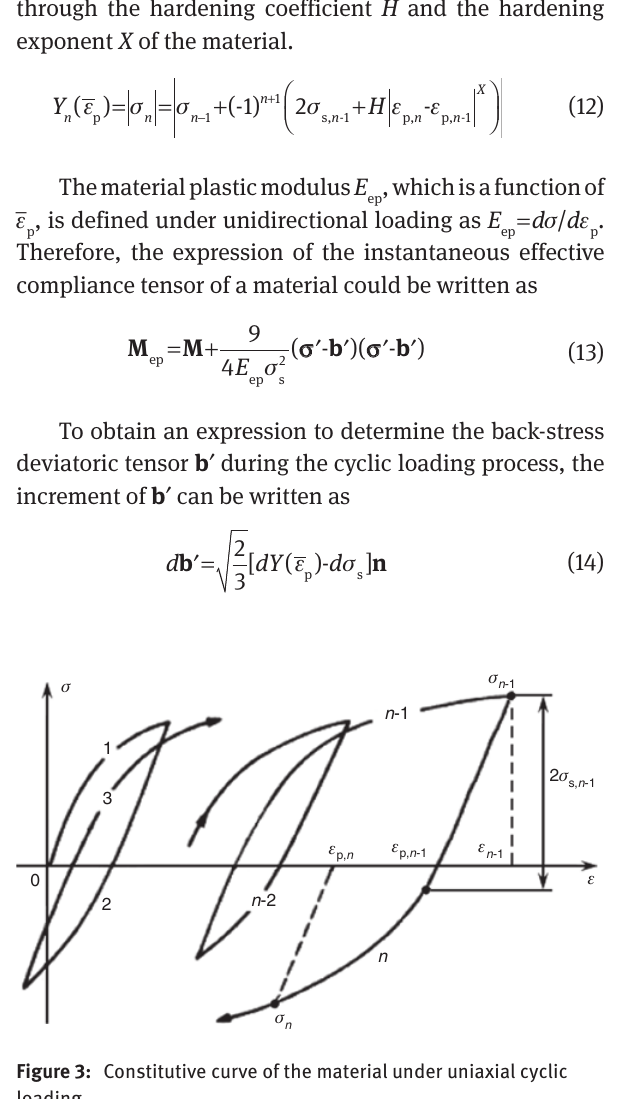
Figure 3: Constitutive curve of the material under uniaxial cyclic